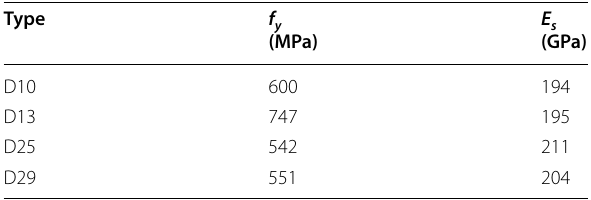
Table 3 Material properties of steel.